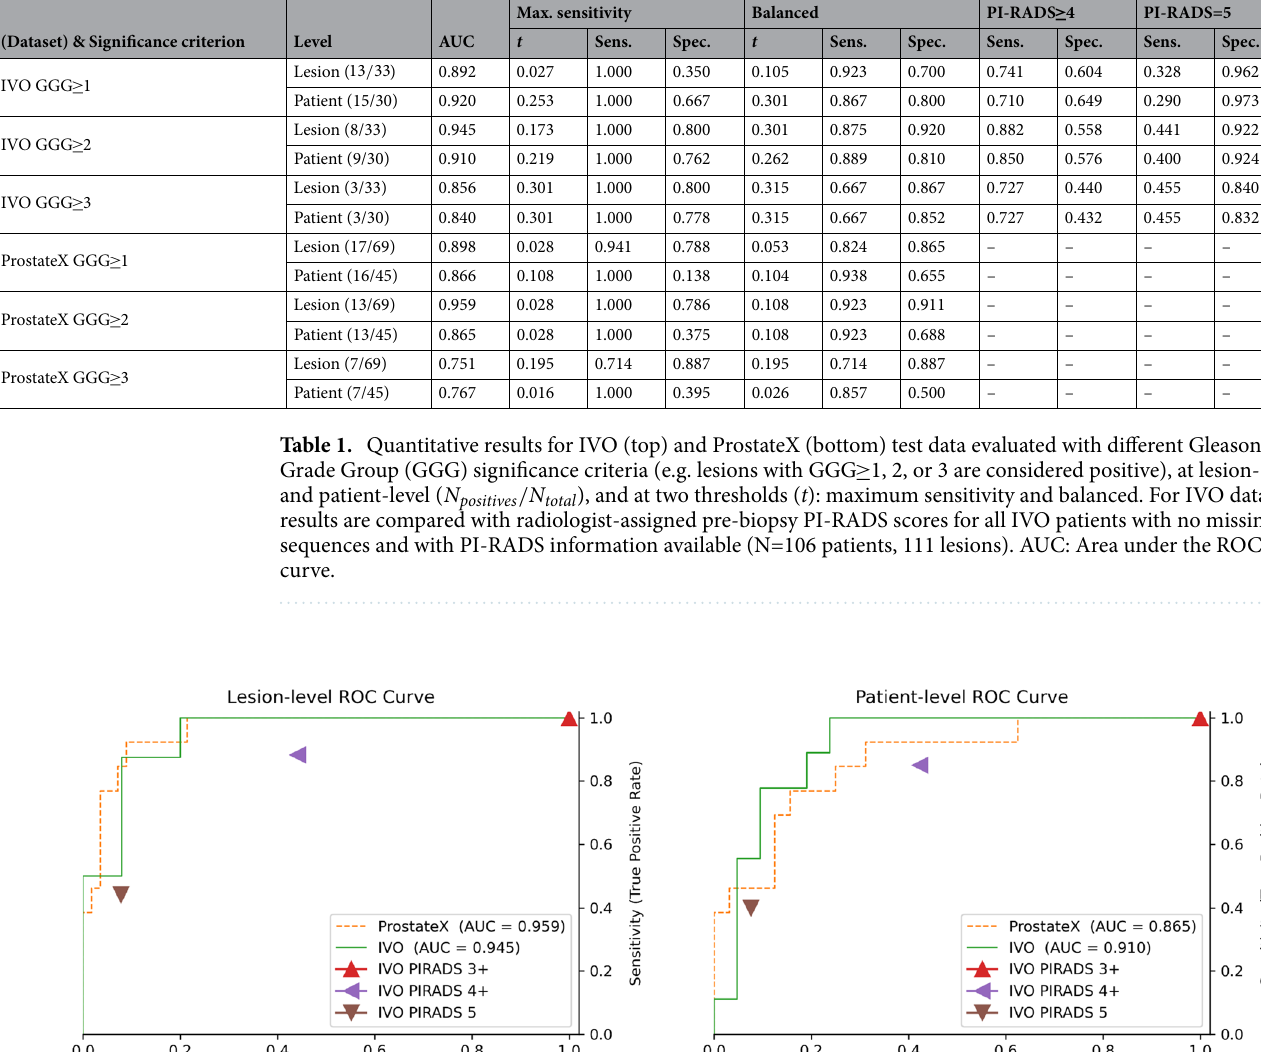
Focusing on the results for the GGG ≥ 2 significance criterion, at the highest sensitivity working point, the model achieves a perfect lesion-level sensitivity of 1 (no csPCa is missed) and a specificity of 0.786 and 0.875 for ProstateX and IVO, respectively (AUCs: 0.959 and 0.945). At the patient level, the specificity falls to 0.375 and 0.762 for each dataset (AUCs: 0.865 and 0.910). For the GGG ≥ 1 significance criterion, the model achieves a lesion-/patient-level maximum sensitivity of 0.941 (spec. 0.788)/1 (spec. 0.138) in the ProstateX dataset, and a maximum sensitivity of 1 (spec. 0.350)/1 (spec. 0.667) in the IVO dataset. In summary, no GGG ≥ 1 patient was missed, although at a cost of low specificity. Using the GGG ≥ 3 significance criterion the model reaches a lesion- and patient-level sensitivity of 0.714 (spec. 0.887)/1 (spec.: 0.395) in the ProstateX dataset, and a maximum sensitivity of 1 (spec. 0.800)/1 (spec. 0.778) in the IVO dataset. Regarding lesion segmentation performance, the mean DSC across all patients for segmenting any type of lesion irrespective of their GGG (including GGG0 benign lesions), was 0.276/0.255 for the IVO/ProstateX dataset when evaluated at the 0.25 segmentation threshold, and 0.245/0.244 when evaluated at 0.5. Qualitative results. Figure 2 shows the output of the model evaluated on two IVO test patients and three Pros- tateX test patients. For the sake of clarity, GGG0 (benign) bounding boxes (BBs) are not shown and, for highly overlapped detections (Intersection over Union, -IoU- > 0.25), only the highest-scoring BB is drawn. Detec- tions with confidence below the GGG ≥ 2 lesion-wise maximum sensitivity threshold (0.173 for IVO, and 0.028